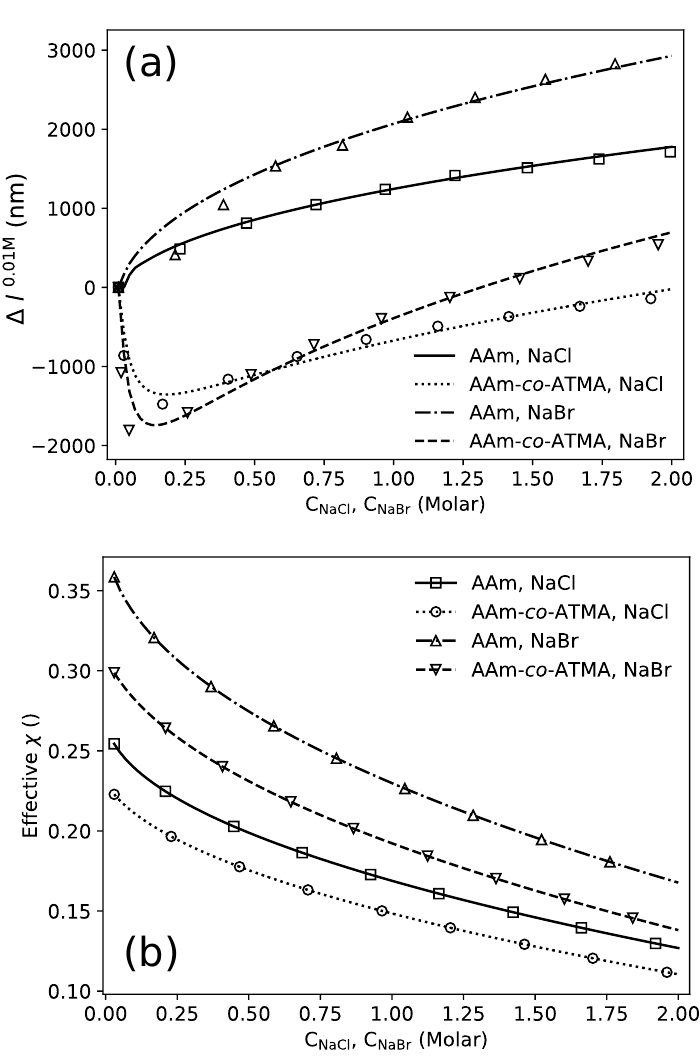
Figure 4. Results obtained with assuming 3 mol% ATMA in the charged gels. ( a ) Comparison between simulation results (lines) and experimental equilibrium data (markers) for all four experiments and ( b ) Effective values of χ as a function of concentration of NaCl or NaBr in aqueous solution for the optimized parameters for AAm and AAm- co -ATMA, 3 mol%